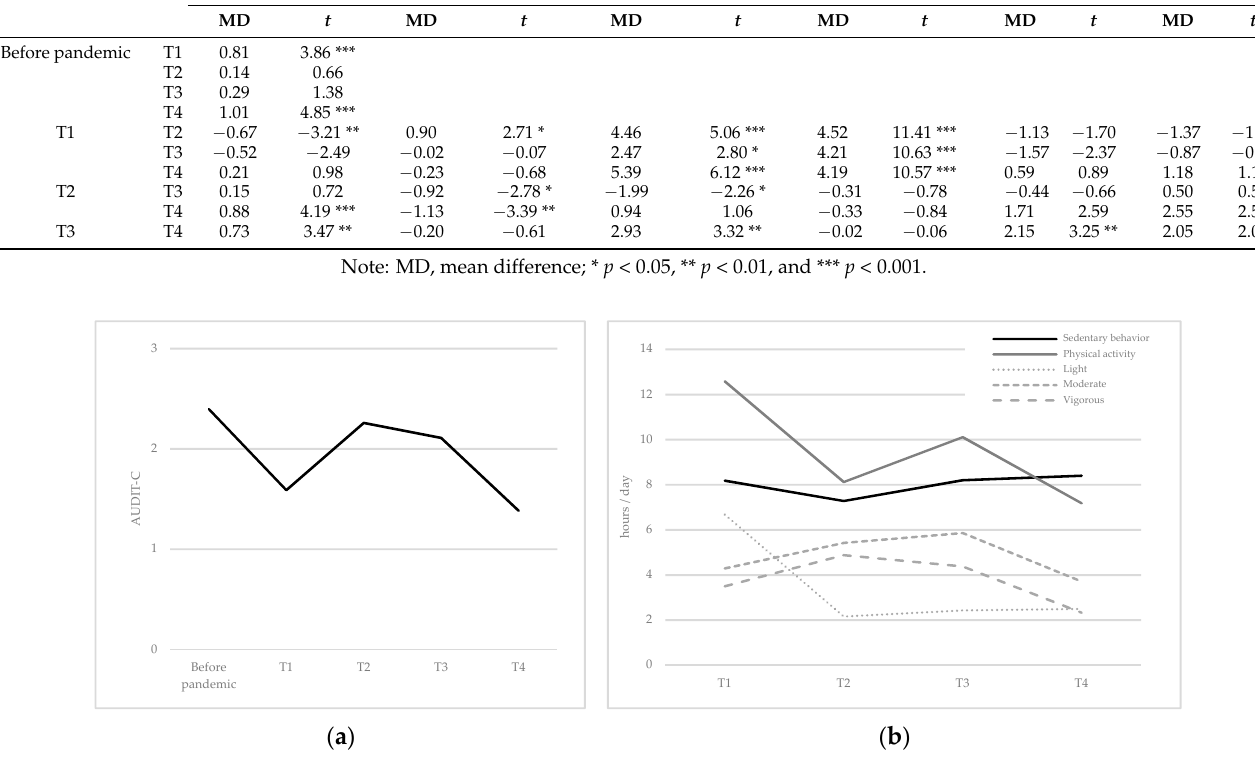
Figure 1. Mean ( a ) alcohol consumption and ( b ) physical activity. Table 2. Repeated measures ANOVA effects.